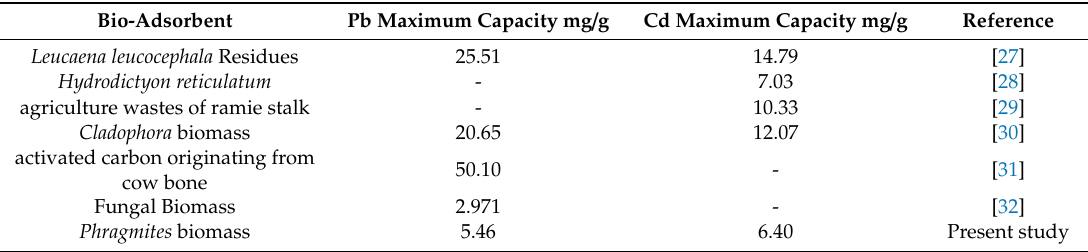
Table 4. A comparison of various bio-adsorbents used to adsorb lead and cadmium ions from aqueous